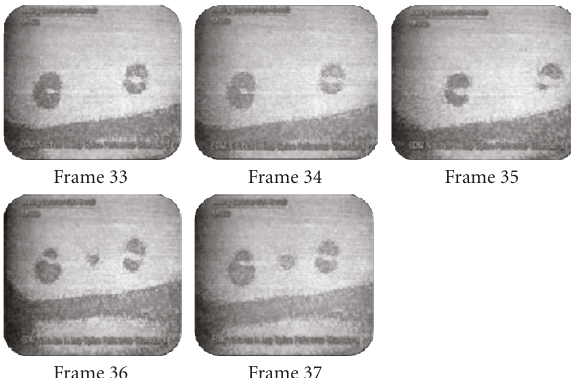
Figure 3: Frames grabbed from one of the available experimental sets.